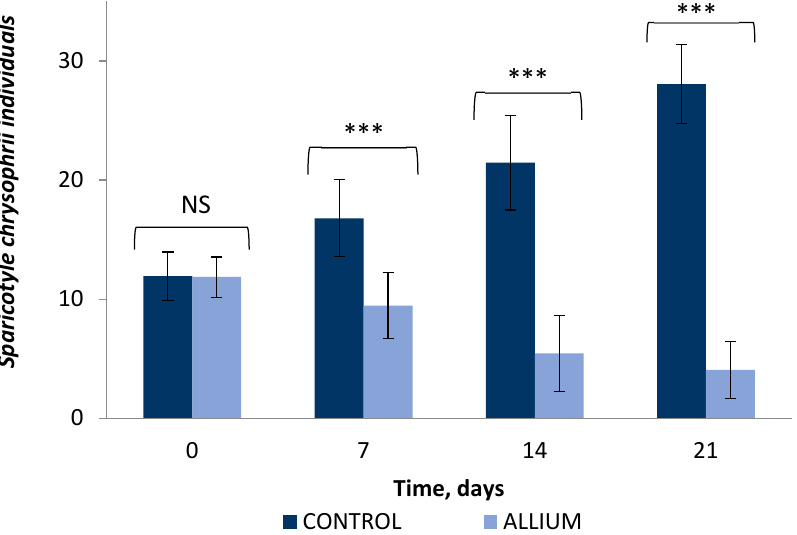
Figure 5. Evolution over time of the number of Sparicotyle chrysophrii parasites in sea bream gills in